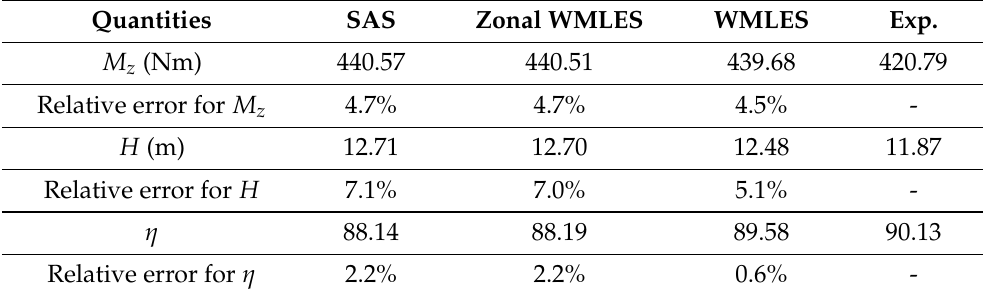
Table 2. Effect of turbulence modeling technique on predicted global quantities, torque, M z , head, H , and efficiency η